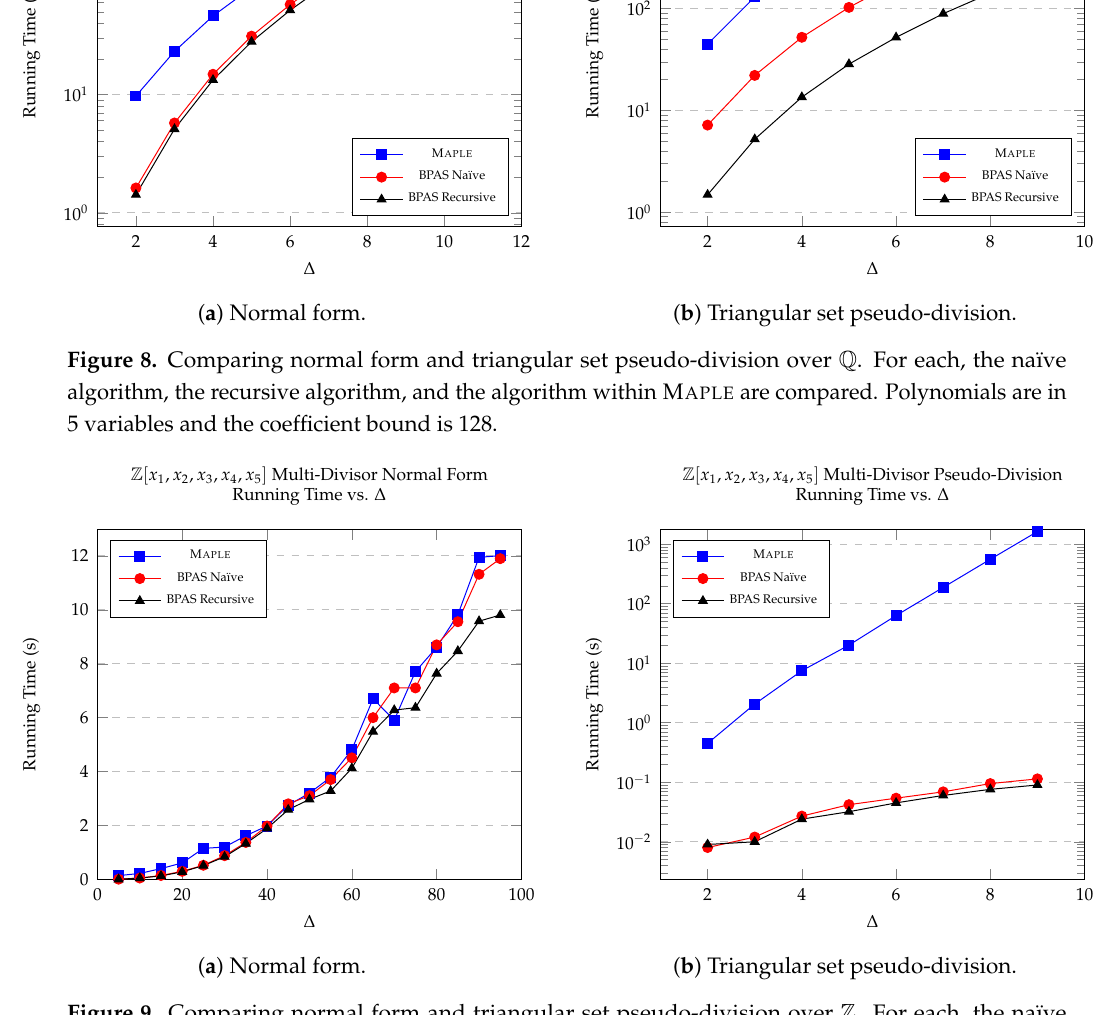
Figure 9. Comparing normal form and triangular set pseudo-division over Z . For each, the naïve algorithm, the recursive algorithm, and the algorithm within M APLE are compared. Polynomials are in 5 variables and the coefficient bound is